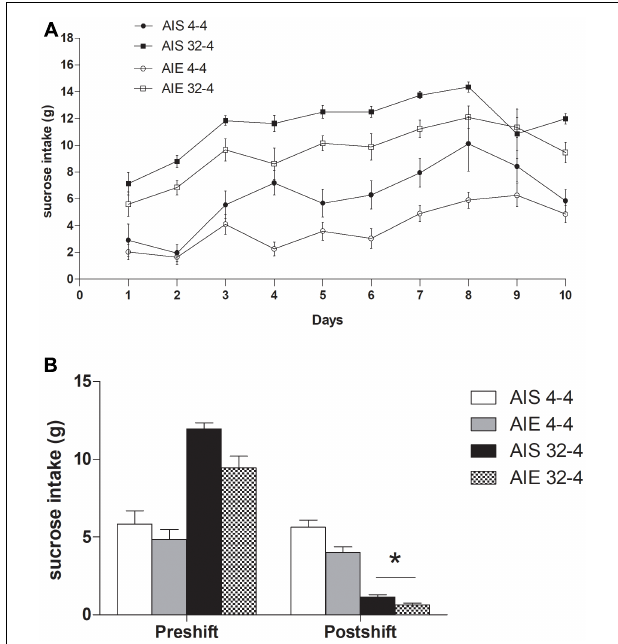
FIGURE 2 | (A) Mean values of sucrose consumption (g) on each of the training sessions in preshift phase and (B) in postshift phase in both groups AIE32-4, AIE4-4, AIS32-4, and AIS4-4. All values are means ± SEM. ∗ p <